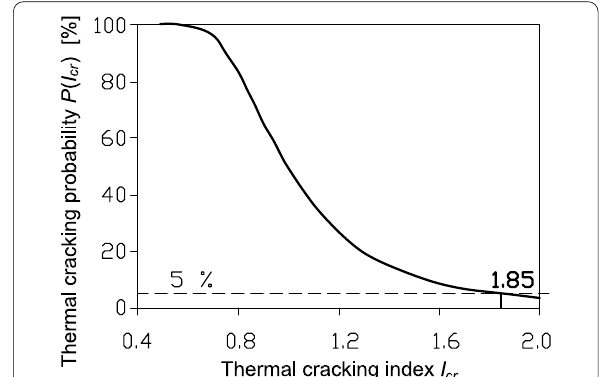
Fig. 3 Dependence between crack index I cr and crack